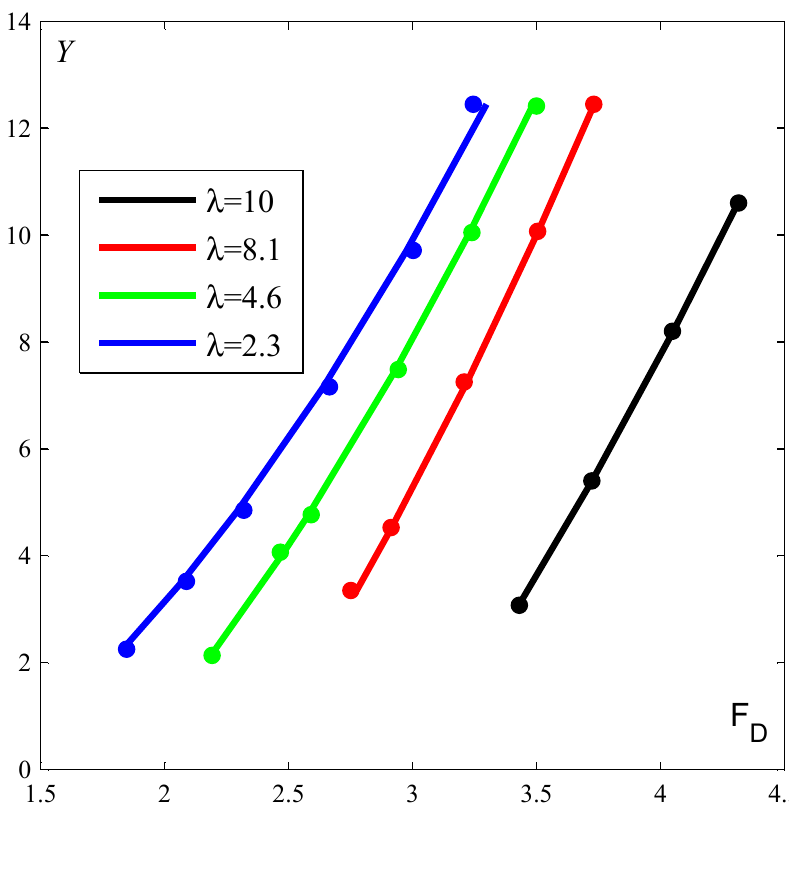
Figure 7. Dimensionless results [Equations (5) and